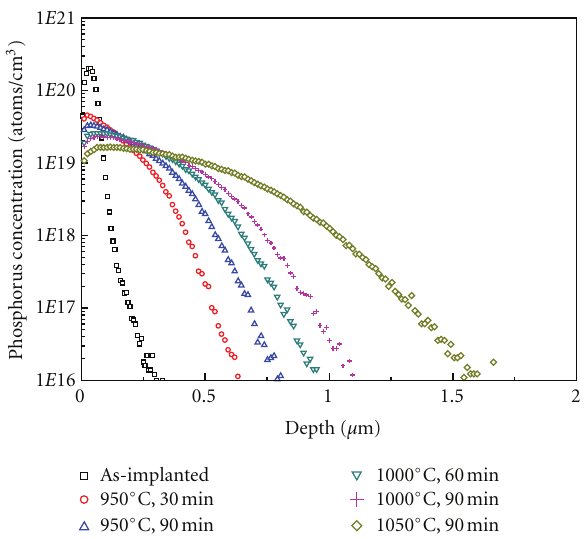
Figure 3: SIMS profiles of phosphorus-implanted emitters as a function of annealing conditions.